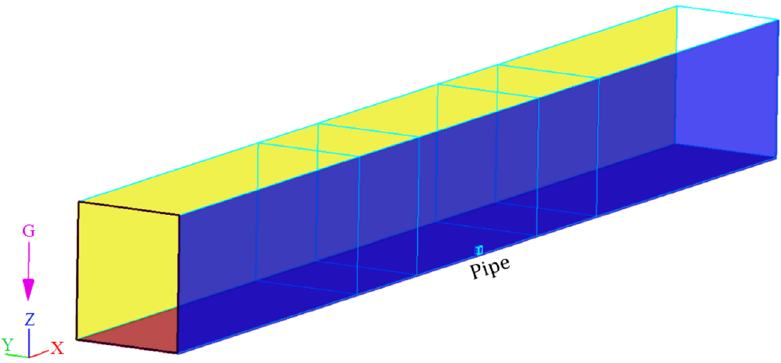
Figure 16. 3D view of the channel components and mesh planes.